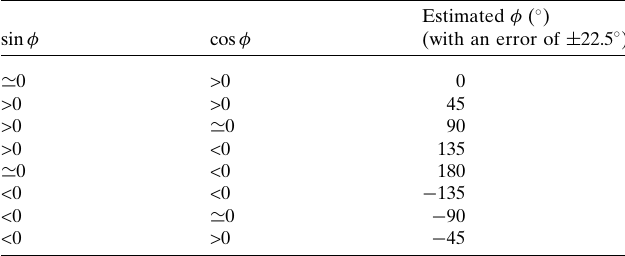
Table 1 Table for determining the three-phase